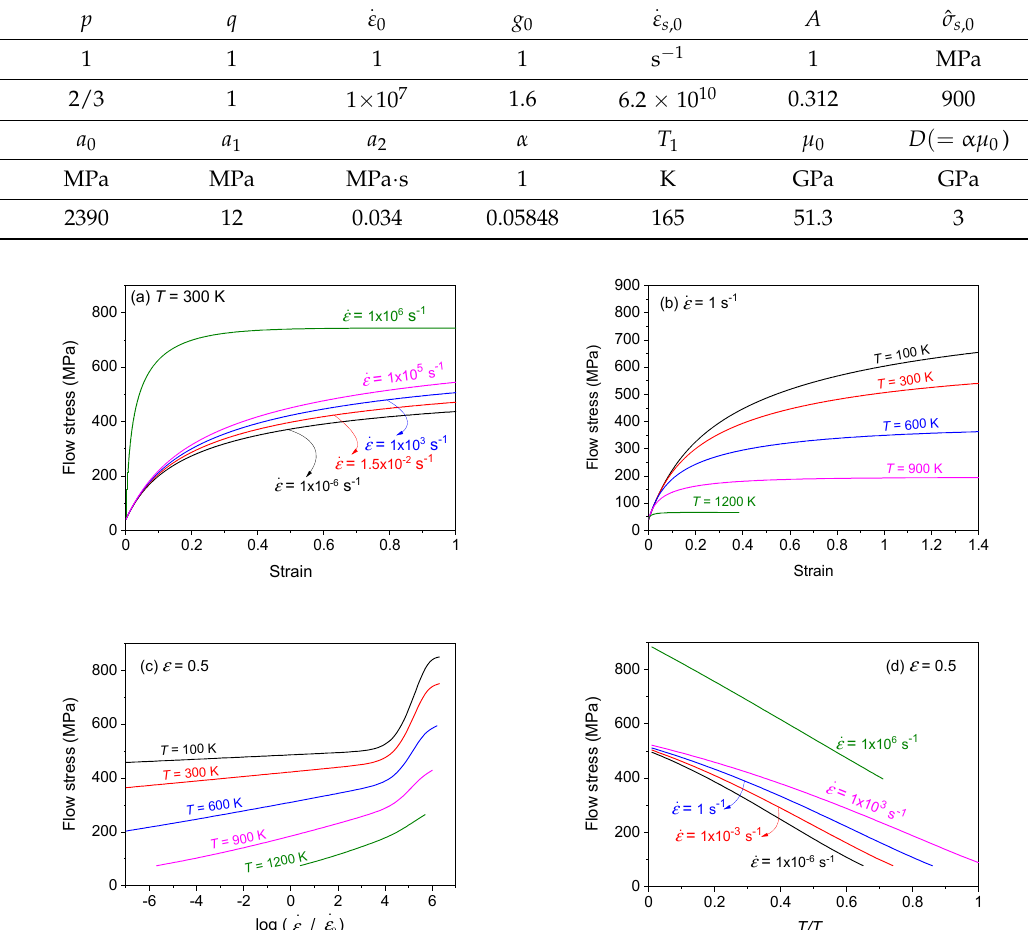
Figure 25. Flow stress–strain curves predicted for copper using the FK model ( a ) at 300 K for different strain rates and ( b ) at 𝜀(cid:4662) = 1 for different temperatures. Change in flow stress at 𝜀 = 0.5 ( c ) with log ( 𝜀(cid:4662) / 𝜀(cid:4662) (cid:2868) ) for different temperatures and ( d ) with T / T m for different strain rates ( 𝜀(cid:4662) ∗ = 1 s − 1 , T m = 1356 K). The hardening of the flow stress with log